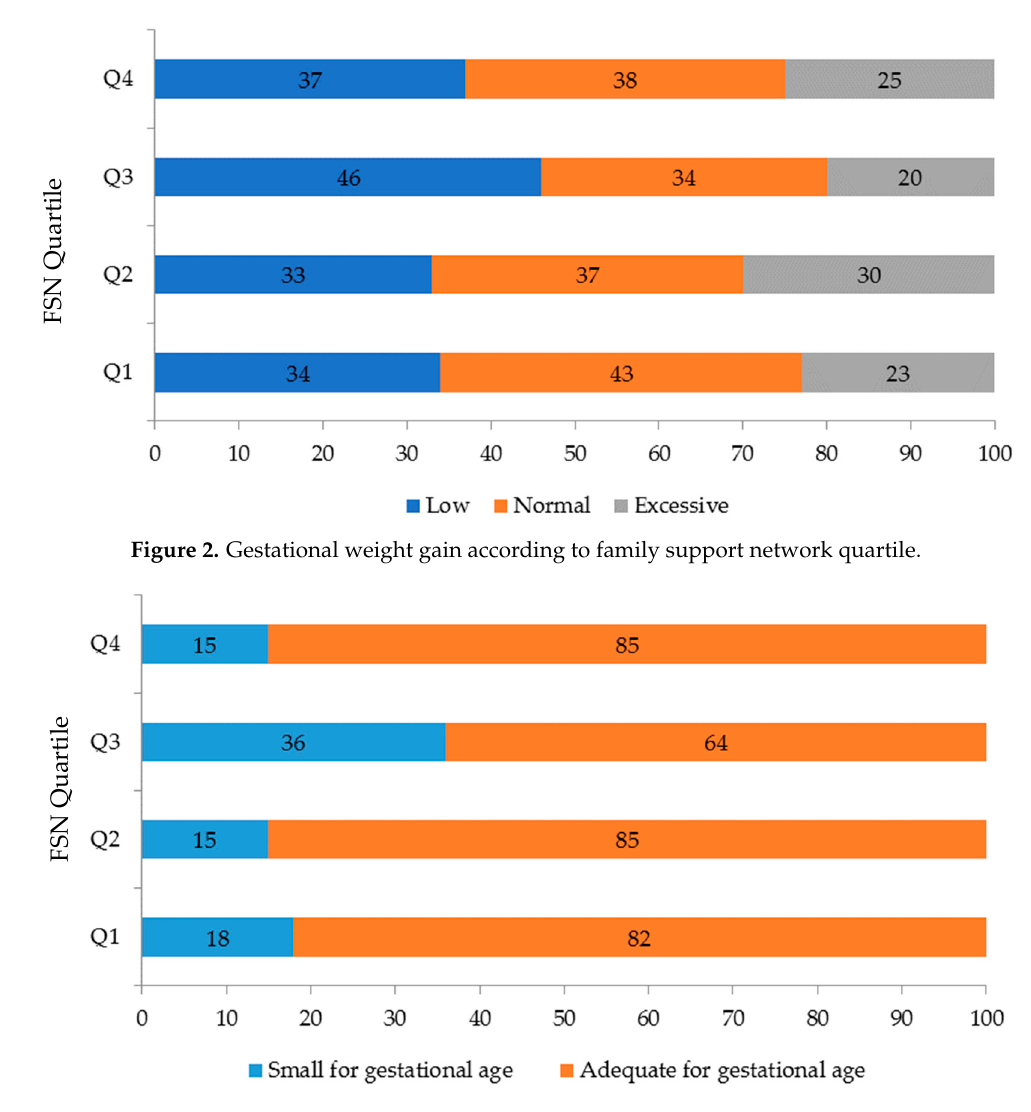
Figure 3. Birth weight according to family support network quartile. Table 3. Associations between small for gestational age newborns and family support network (in quartiles) provided to pregnant adolescents.